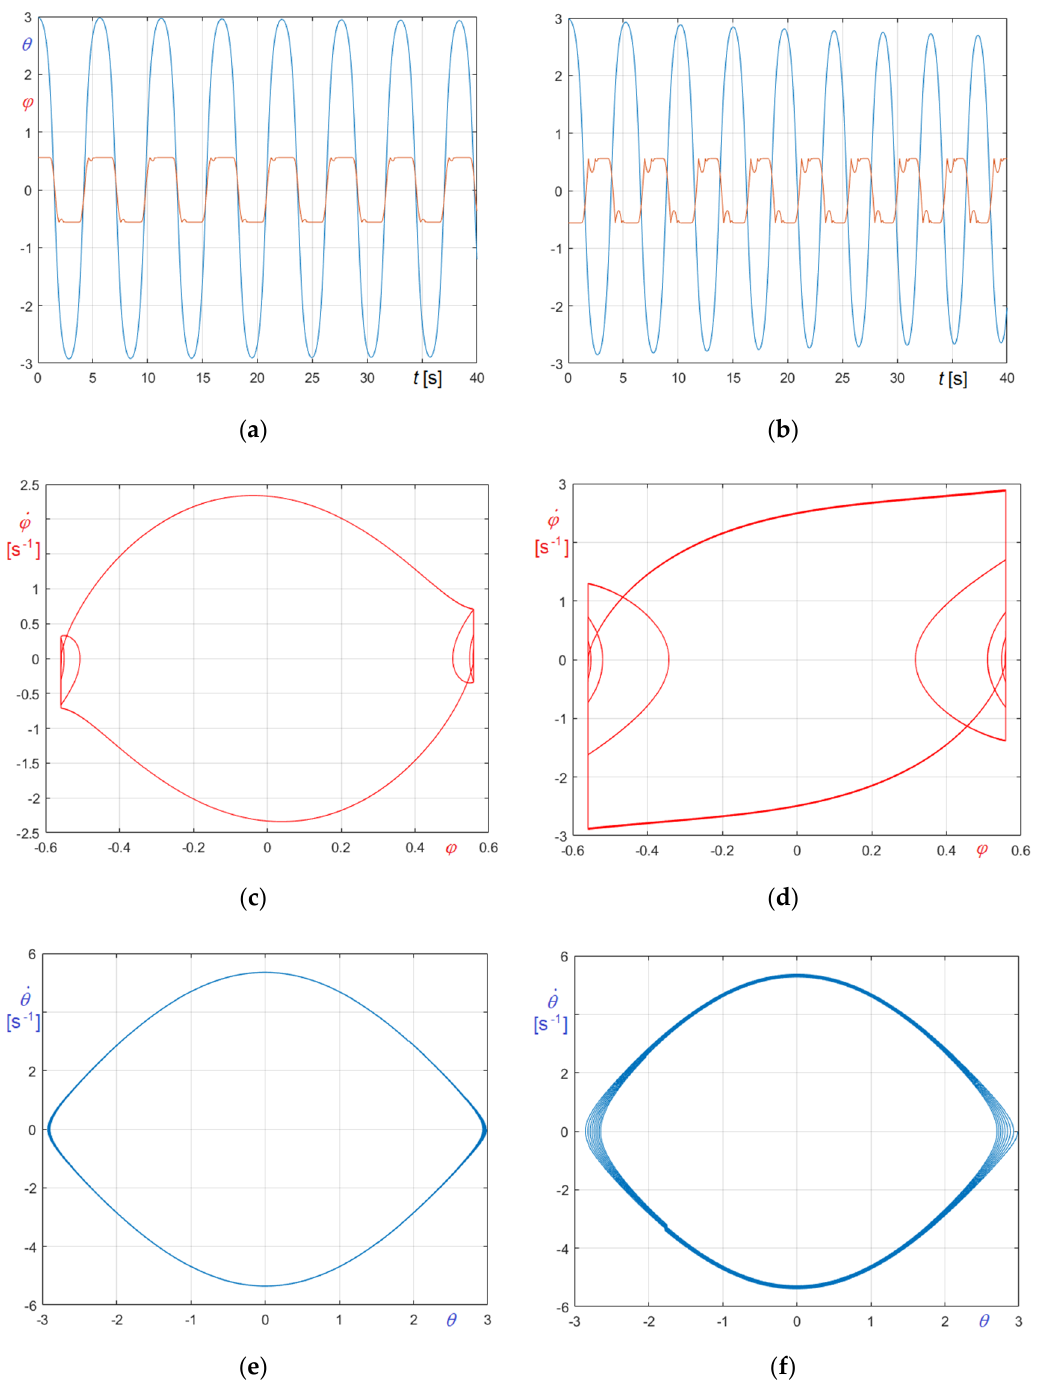
√ (cid:16) (cid:17) Figure 12. Undamped free oscillations of St. Mary’s tenor bell in case I (cid:3435)(cid:1837) = √0.2(cid:3439) : ( a ) (cid:2016) = (cid:2016)(cid:4666)(cid:1872)(cid:4667) and K = Figure 12. Undamped free oscillations of St. Mary’s tenor bell in case I 0.2 : ( a ) θ = θ ( t ) and ϕ = ϕ ( t ) curves for case I.a; ( b ) θ = θ ( t ) and ϕ = ϕ ( t ) curves for case I.b; ( c ) . ϕ − ϕ curves for case I.a; (cid:2030) = (cid:2030)(cid:4666)(cid:1872)(cid:4667) curves for case I.a; ( b ) (cid:2016) = (cid:2016)(cid:4666)(cid:1872)(cid:4667) and (cid:2030) = (cid:2030)(cid:4666)(cid:1872)(cid:4667) curves for case I.b; ( c ) (cid:2030)(cid:4662) − (cid:2030) curves for case . . . ϕ − ϕ θ − θ curves for case I.a; ( f ) θ − θ curves for case I.a; ( d ) (cid:2030)(cid:4662) − (cid:2030) curves for case I.b; ( e ) (cid:2016)(cid:4662) − (cid:2016) curves for case I.a; ( f ) (cid:2016)(cid:4662) − (cid:2016) curves for case I.b. ( d ) curves for case I.b; ( e )